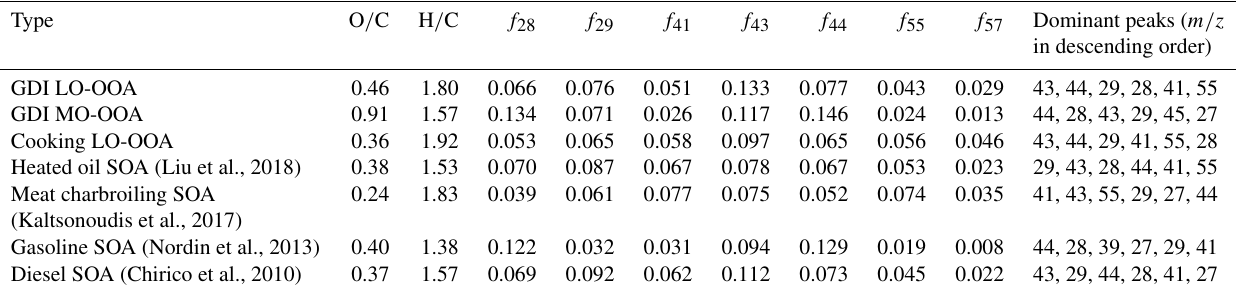
Table 5. A summary of elemental ratios and dominant peaks among various SOAs. Type